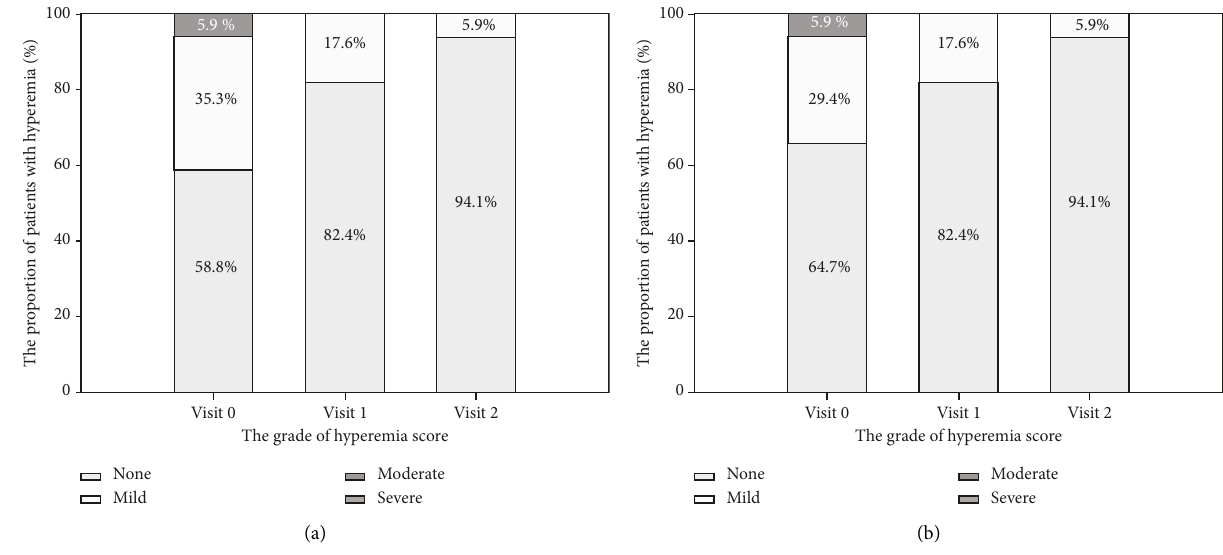
Figure 2: proportion of patients by hyperemia severity per visit. (a) Bulbar conjunctiva. (b) Palpebral conjunctiva. Table 3: Results of secondary endpoints at each